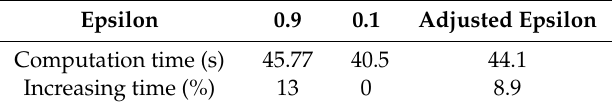
Figure 12. The state-action values (Q values) with different values of epsilon: ( a ) epsilon = 0.9; ( b ) adjustable epsilon; ( c ) epsilon = 0.1. Table 5. Increasing learning time with a different value of epsilon.